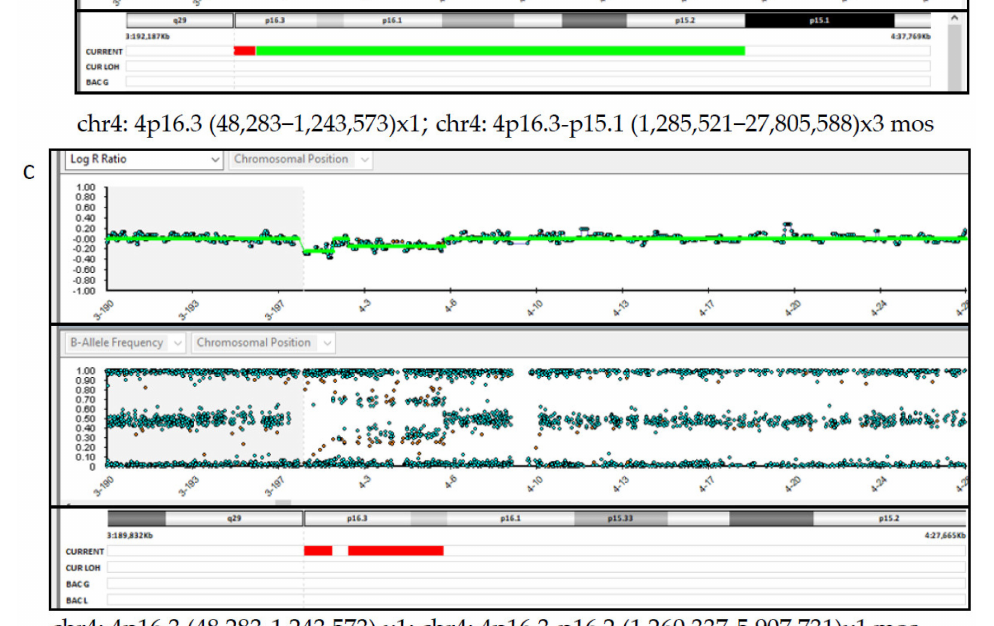
Figure 4. SNP-array analysis of the placenta tissues. ( a , b ). Placenta sample 1 and 3 DNA (P1 and P3) showed a 1.2 Mb deletion (arr ((GRCh37) 4p16.3 − p15.1 (1,285,521–27,805,588) × 3 mos). ( c ). Placenta sample 2 DNA (P2) showed a 1.2 Mb deletion (arr (GRCh37) 4p16.3 (48,283–1,243,573) × 1) and a 4.6 Mb deletion, both on the chromosome 4p (arr (GRCh37) 4p16.3-p16.2 (1,260,337–5,907,731) × 1